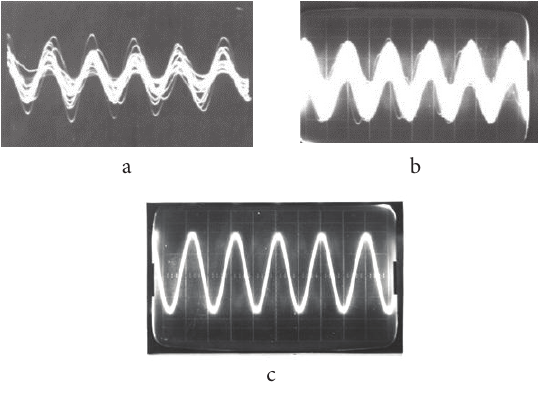
Figure 11. Oscillograms of the friction modes: a − transition mode from boundary to mixed lubrication; b − transition mode from mixed to hydrodynamic lubrication; c − hydrodynamic